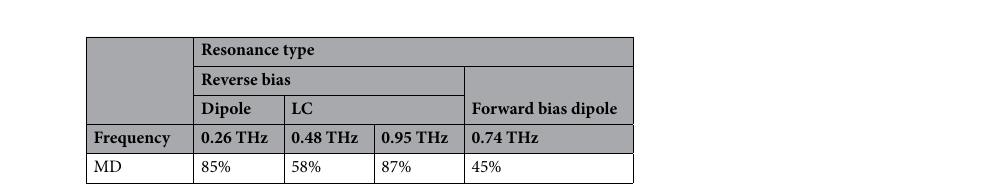
Table 2. The Modulation depths of the LC and dipole resonances at their corresponding